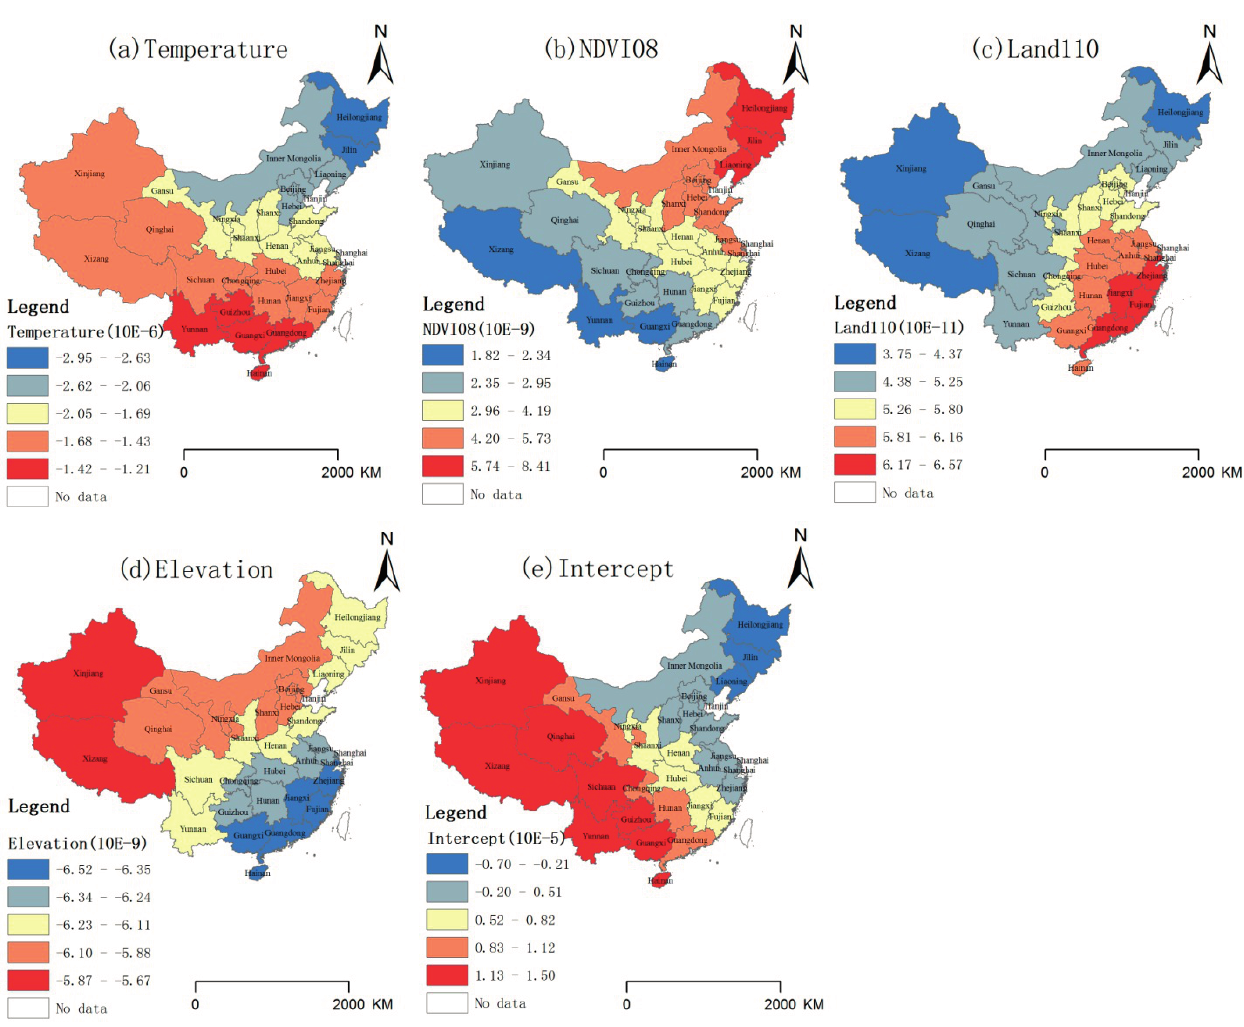
Figure 6. GWR model coefficients,